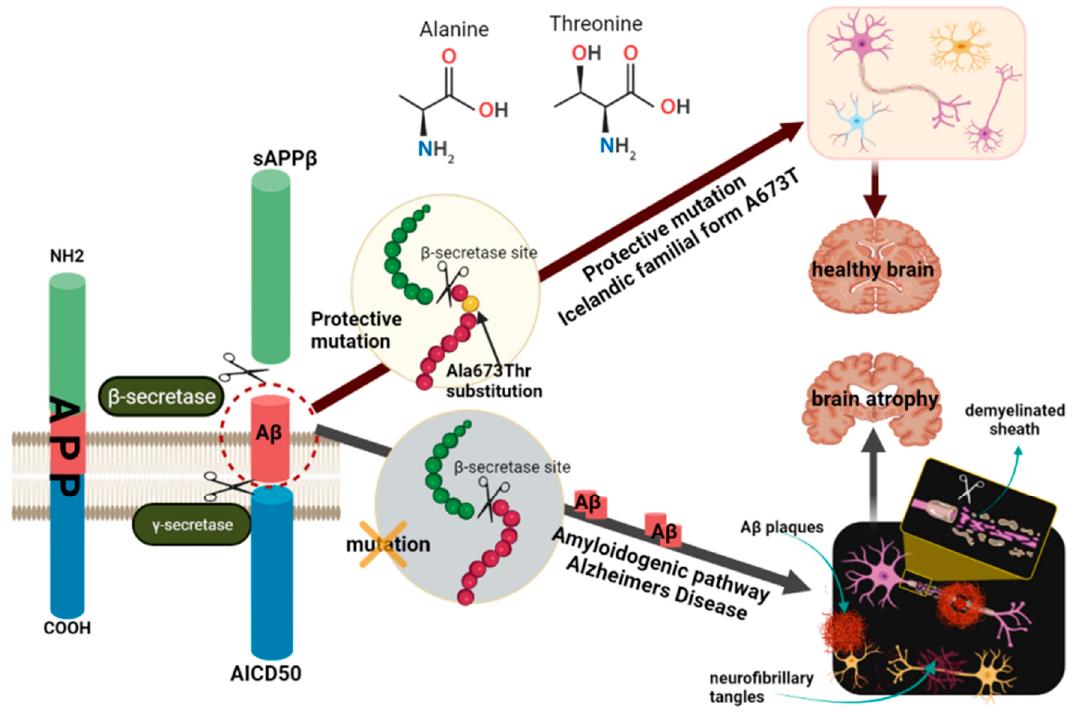
Figure 2. Schematic representation of the molecular mechanisms of A673T protection against amyloid pathology. One of the pathways for APP processing is the formation of toxic amyloidogenic peptides, which accumulate and form amyloid plaques. Two cleavages are required for the release of A β from the APP molecule, one in the extracellular domain by β -secretase and another in the transmembrane region by γ -secretase. APP cleavage by β -secretase generates a fragment called β -APP and another smaller fragment that is embedded in the membrane until further cleavage in the presence of γ -secretase. The A673T protective mutation in the APP gene, located near β -secretase, encodes an alanine to threonine substitution. This mutation, also known as A2T, inhibits proteolytic cleavage at the cleavage site of APP by β -secretase. The absence of this mutation leads to cleavage in the presence of γ -secretase, leading to the release of A β peptides, especially A β 42, and the formation of amyloid plaques. Neurofibrillary tangles also form, which together with β -amyloid plaques, lead to impaired synaptic transmission and ultimately to neuronal death. In the case of carriers of the A673T mutation, cleavage by γ -secretase with the formation of the A β 42 peptide is thus avoided, the carriers being protected from developing AD. The figure was prepared with BioRender. AD, Alzheimer’s disease; APP, amyloid precursor protein; A β , amyloid-beta peptide.